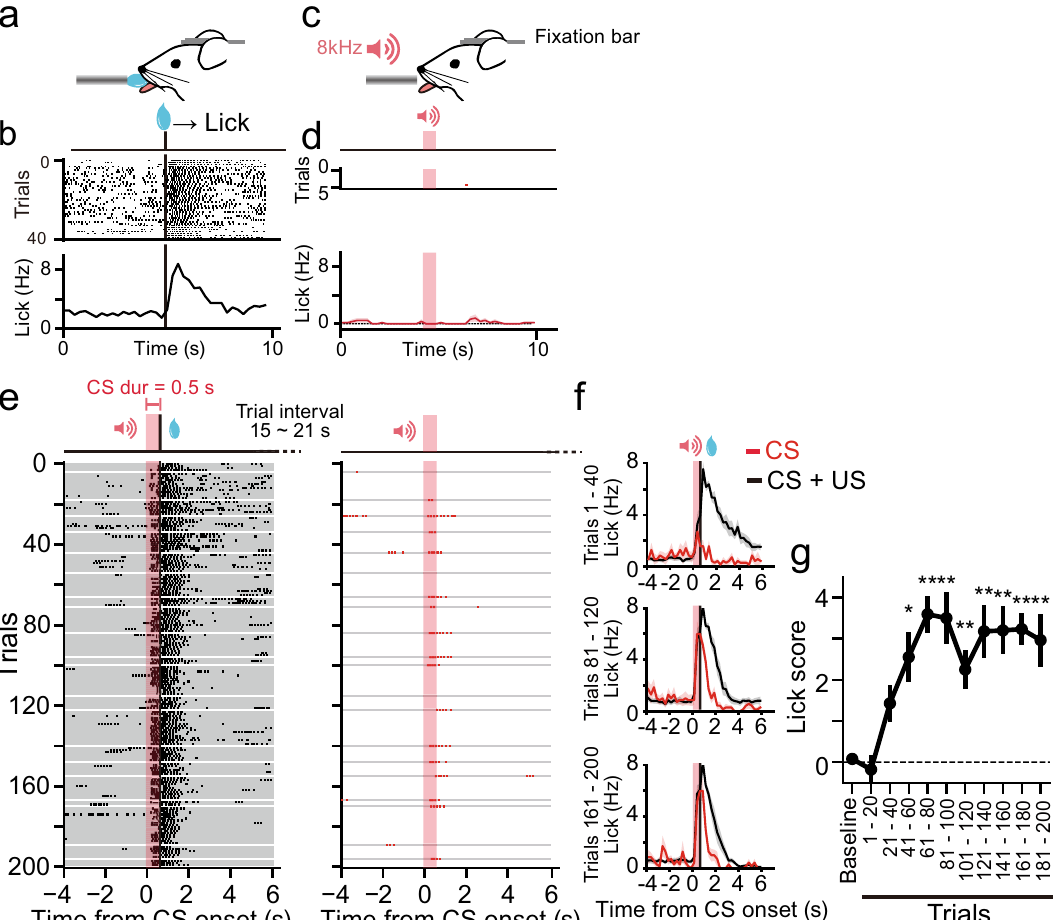
Figure 1. Pavlovian conditioning in head-restrained mice. ( a ) A schematic diagram of the behavioural setup. Mice were head-restrained using a chronically implanted bar. A drop of glucose water was presented as an US to directly touch the mouth of the mouse from a tube that monitored the licking responses. ( b ) Raster plots (upper) and an averaged peristimulus time histogram (PSTH, bottom) for the licking responses to US presentation from a representative mouse. The US was presented 40 times at 10-s intervals. Black vertical bars indicate the onset of US presentation. ( c ) A short tone (8 kHz, 70 dB, 0.5 s) presentation without US. ( d ) Raster plots (upper) and an averaged PSTH (bottom, n = 7 mice) for licking responses to CS before conditioning. The baseline measurement consisted of five consecutive trials with CS-only presentation. Red shades indicate the period of CS presentation. ( e ) Raster plots for licking during conditioning with a CS duration of 0.5 s in a representative mouse. The session consisted of 180 trials with a paired presentation of CS and US (left) and pseudo-randomly inserted 20 trials with CS-only presentation (right). “CS dur” indicates the duration of CS presentation. US was presented at the offset of CS. Intervals between CS presentations were pseudo-randomly varied between 15 and 21 s. Each gray line indicates a single trial. ( f ) Averaged PSTHs for the licking responses in the first 20% of the trials (1–40, upper), the third 20% of the trials (81–120, middle), or the last 20% of the trials (161–200, bottom) during CS + US trials (black trace) or CS-only trials (red trace). In the CS-only trials, the average of four trials was included in the indicated periods are shown. The shadows indicate SEM. n = 7 mice. ( g ) Lick scores (“Methods”) plotted against time. * P < 0.05, ** P < 0.01 ( n = 7 mice, Kruskal–Wallis test). Error bars indicate